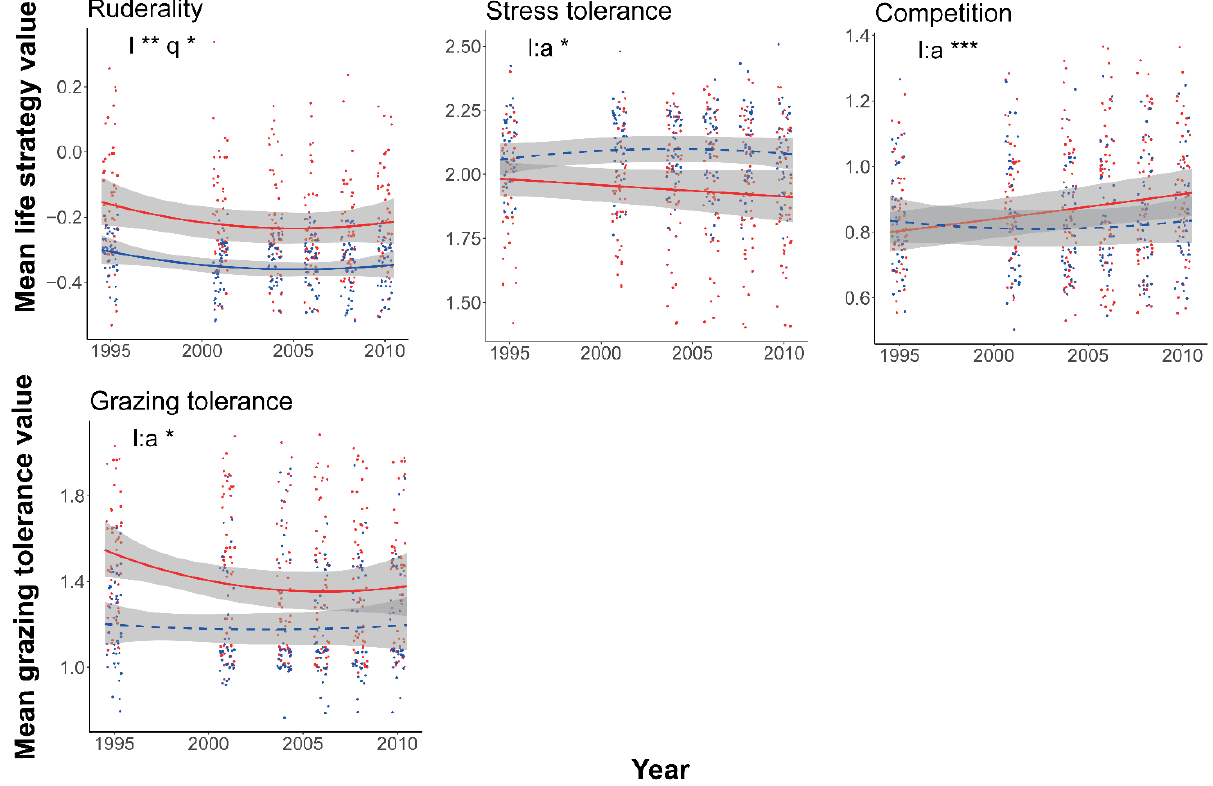
Figure 4. Trends of mean life strategy values and mean grazing tolerance for GC-areas (grazing cessation, red) and GCR-areas (grazing cessation plus rewetting, blue). Regression lines and confidence intervals from individual models are displayed. Solid lines show significant trend components. Dashed lines show the model fit of both trend components, if neither of them is significant. Labels denote significant trend differences or significant overall trends derived from the common model. Dots indicate observed values on single plots. Outliers are not shown. l = linear time component; q = quadratic time component; a = area type; a colon indicates an interaction. Significance levels: *: p ≤ 0.05; **: p ≤ 0.01; ***: p ≤